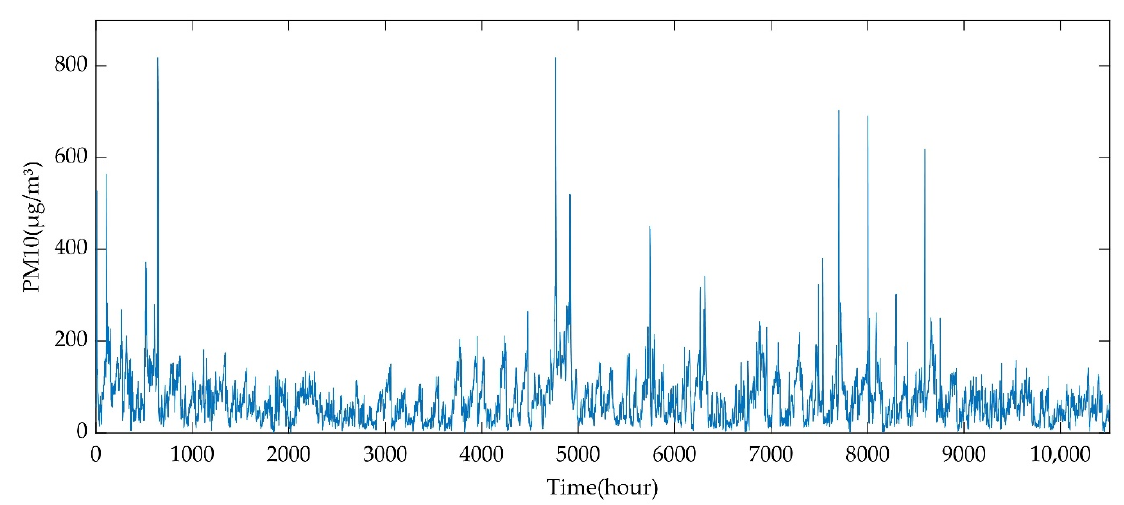
Figure 2. Original particulate matter (PM10) concentration time series.